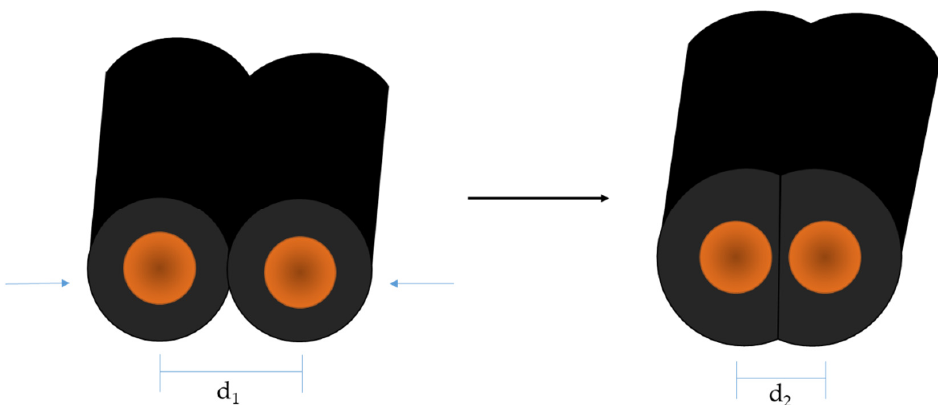
Figure 1. Schematic cross-section of carbon-filled, silicone-coated metal yarn and their deformation upon strain that causes the change in electrical resistance.